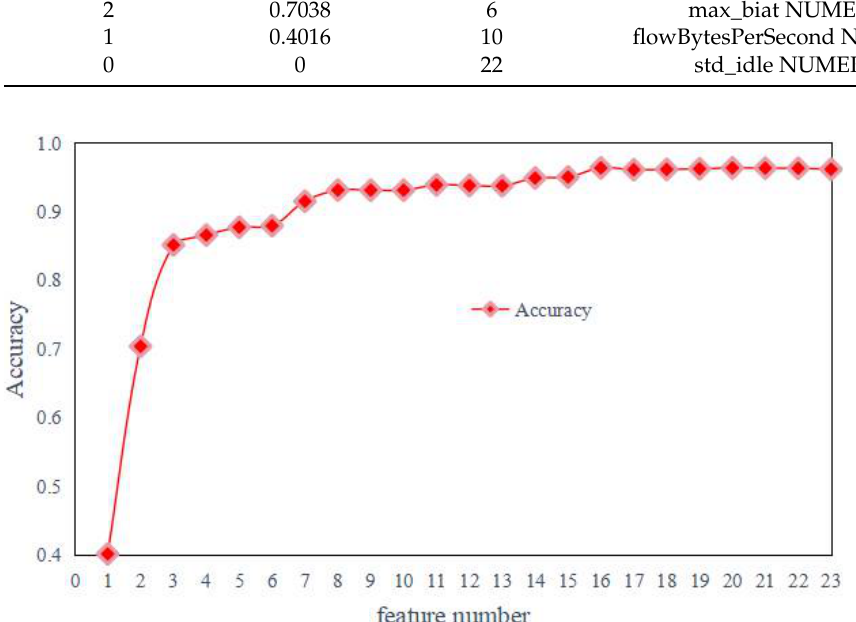
Figure 8. Effect of number of features on model accuracy.